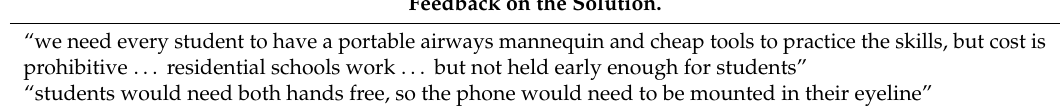
Table 3. Data Supporting “How can I solve the problem?” step of the Pedagogy before Technology model, as per Figure